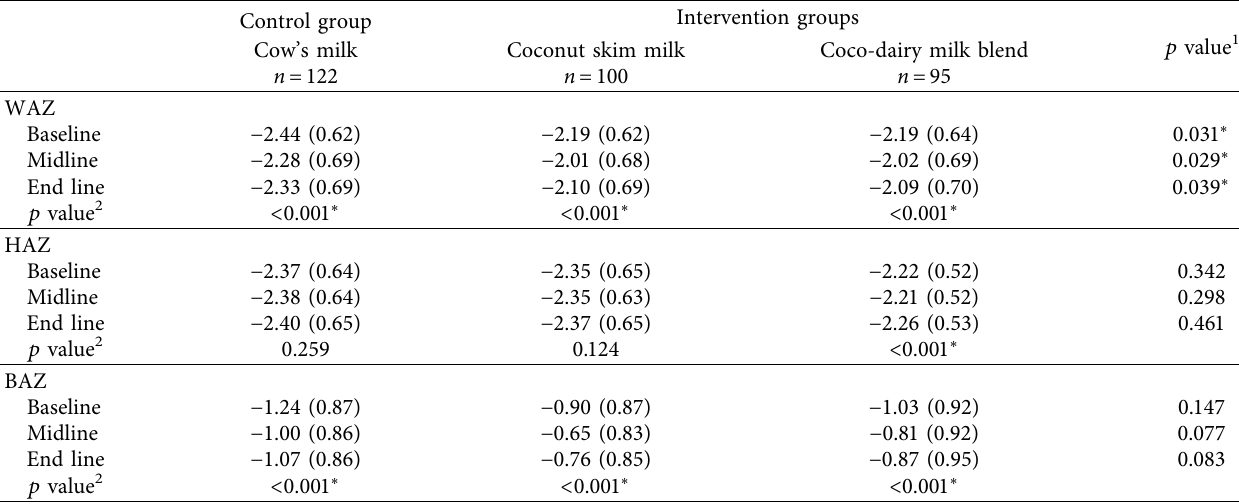
Table 5: Mean weight-for-age z -scores (WAZ), height-for-age z -scores (HAZ), and BMI-for-age z -scores (BAZ) of child participants by group and time